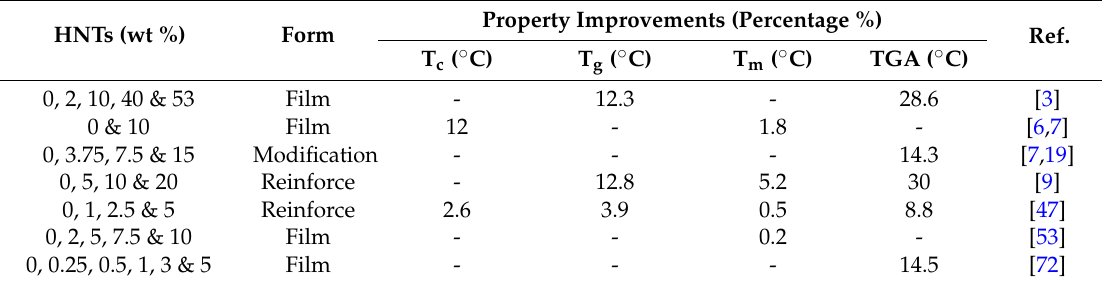
Table 3. HNT-based PVA composites with the range of HNTs loading and the intended/achieved target thermal properties for each composition.